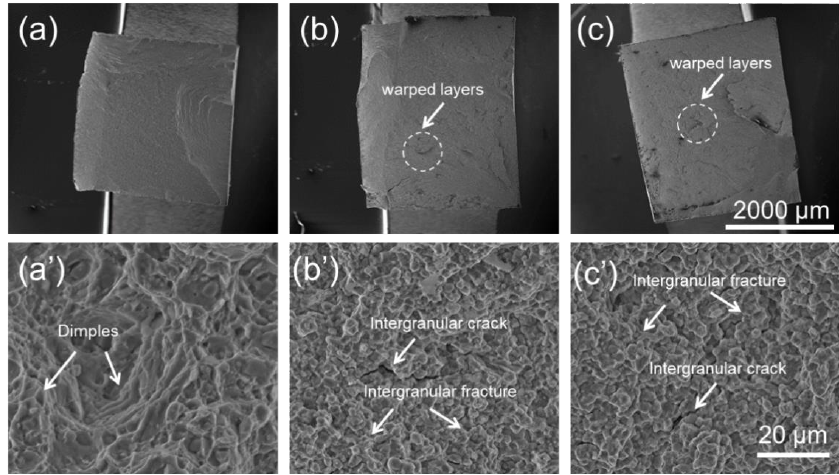
Figure 10. Fracture surfaces for SL at 550 °C ( a , a’ ), 750 °C ( b , b’ ), and 830 °C ( c , c’ ).